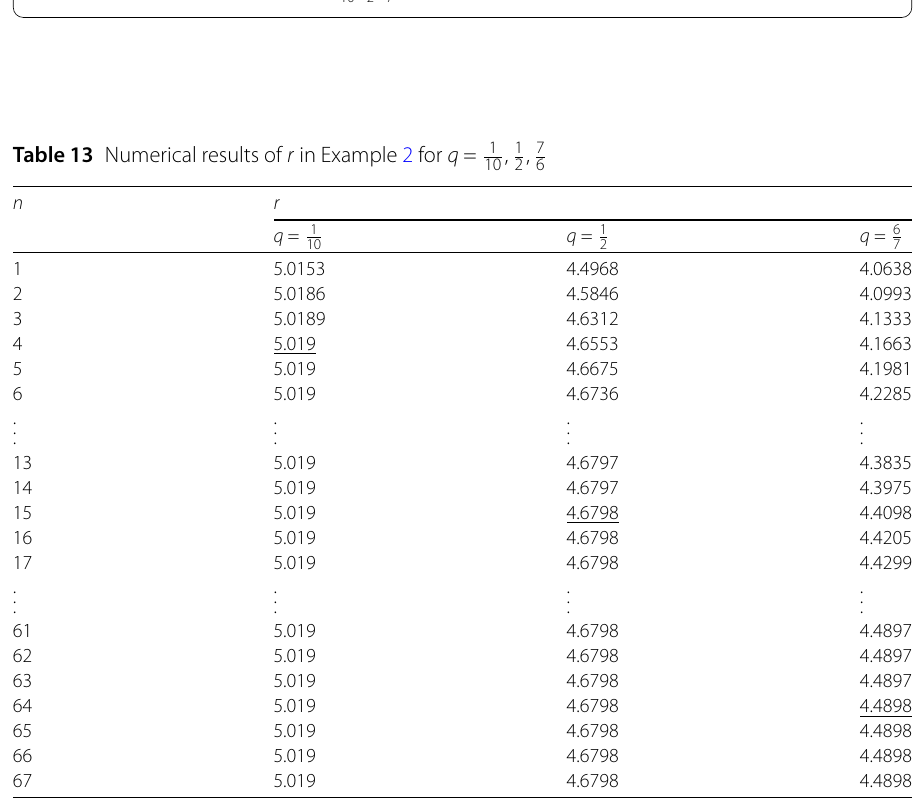
, 1 , 6 in Example 2 10 2 7